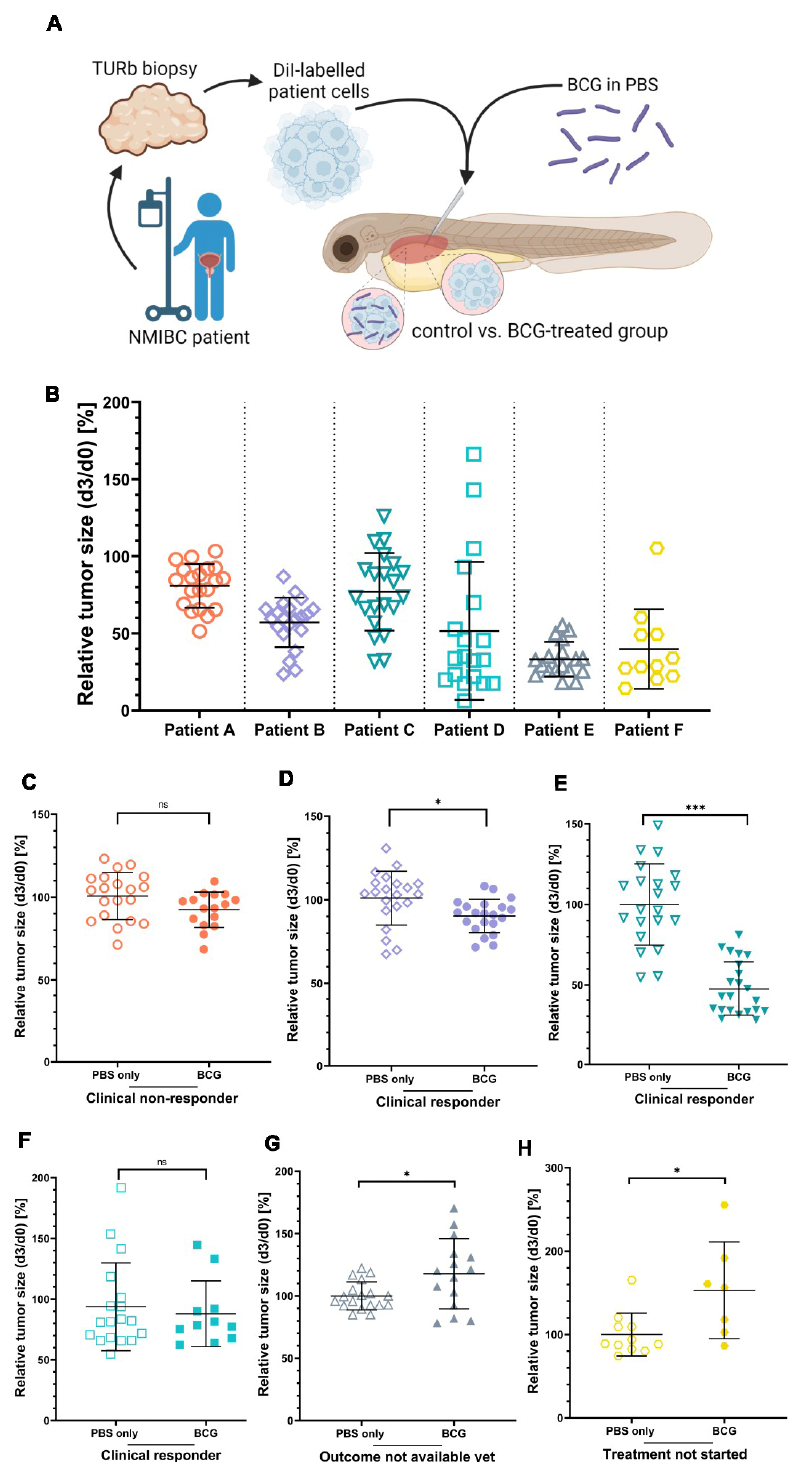
Figure 5. The clinical responses of three NMIBC patients are mirrored by the BCG treatment response of ZTX models. ( A ) Cartoon illustrating the experimental set-up. Cryo-preserved patient tumor tissues were dissociated, fluorescently labelled, and subcutaneously injected into the PVS of 48 h old zebrafish larvae with or without BCG. ( B ) Graph showing the relative tumor size of the six different ZTX models without BCG treatment quantified at 3 days post-injection (dpi). ( C – H ) Graphs comparing relative tumor sizes of BCG co-injected and untreated control ZTX groups quantified at 3 dpi. n = 20 injected embryos per group; ns = not significant; * = p < 0.05; *** = p <